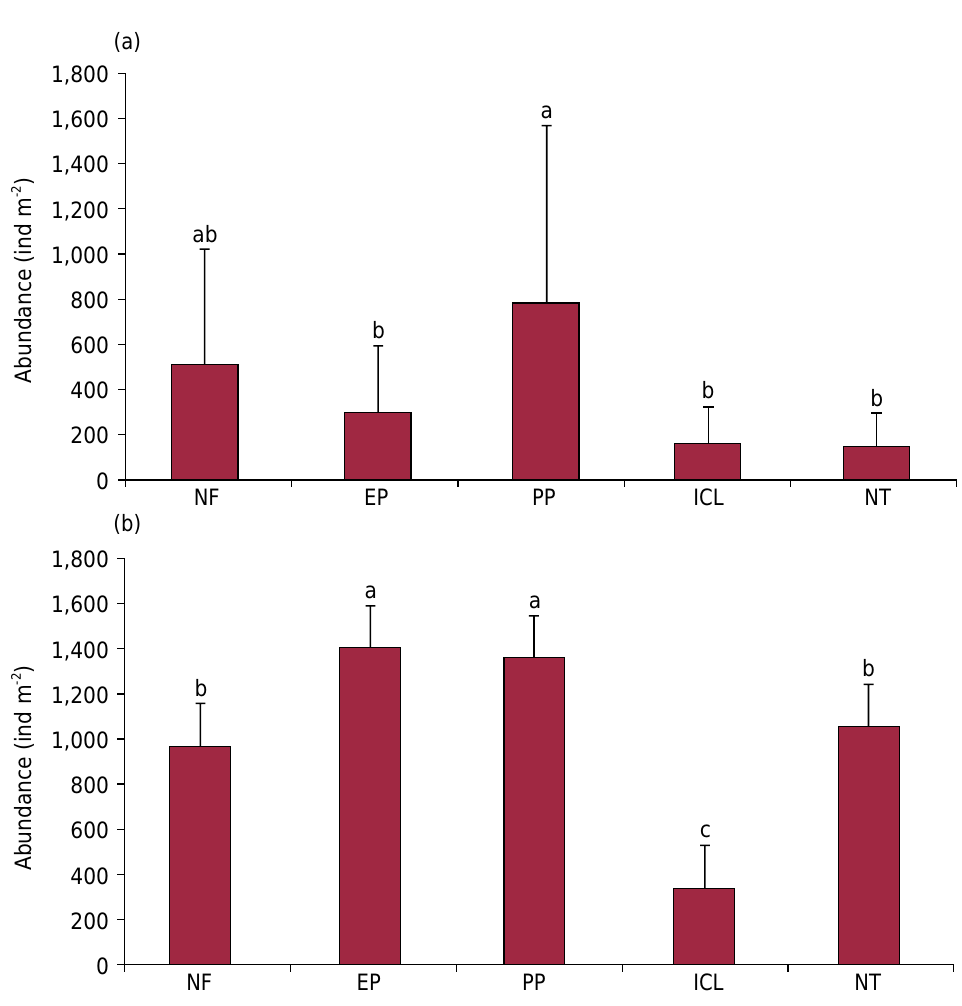
Figure 3. Abundance of soil macrofaunal groups in the land use systems: native forest (NF), eucalyptus plantations (EP), perennial pasture (PP), integrated crop-livestock (ICL), and no-tillage (NT), in the summer (a) and winter (b), in the eastern region of Santa Catarina, Brazil. Different letters above the bars reflect statistical difference using the t test (p<0.05) and line bars are standard